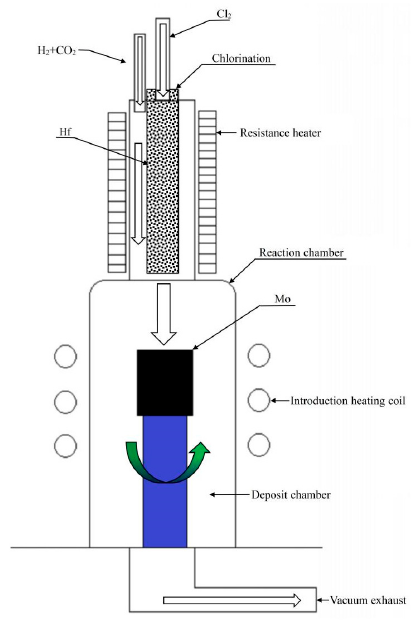
Figure 1. CVD schematic diagram.